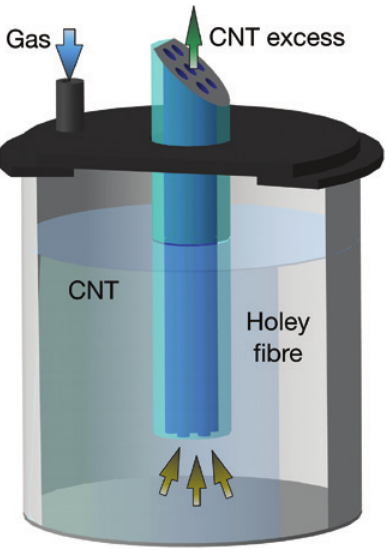
Figure 14: Technology of hollow core fibre filling with